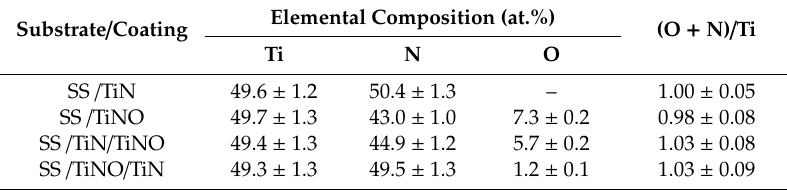
Table 1. The elemental composition of the investigated specimens before the corrosion test. Elemental Composition Substrate / Coating